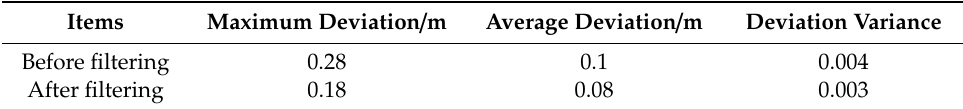
Table 2. Error statistics before and after the filtering process.